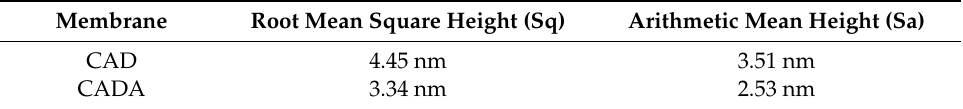
Figure 8. AFM micrographs of the CA membranes: ( a ) CDA membrane and ( b ) CADA (size of the micrographs: 1 µ m × 1 µ m). Table 3. AFM Surface roughness parameters of the as-prepared